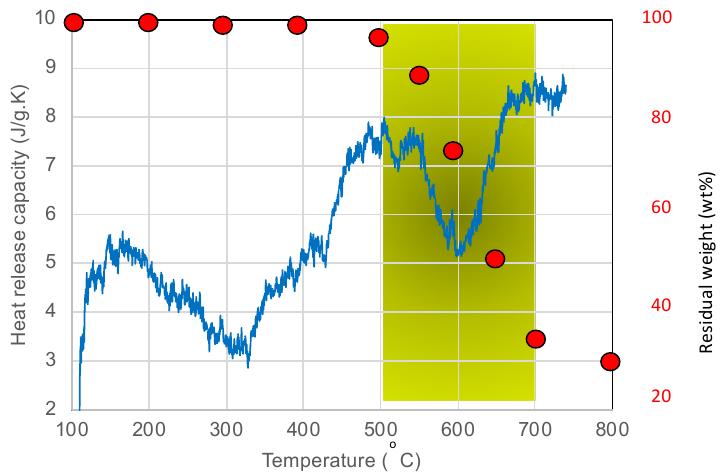
Figure 7. A microcombustion calorimetric (blue line) and TGA (red closed circles) thermograms of poly(BAF-oda-fu). The main thermal degradation temperature range is indicated by a green belt between 500 and 700 °C.